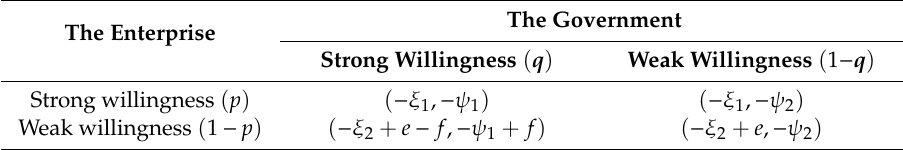
Table 2. The payo ff matrix under the static punishment mechanism